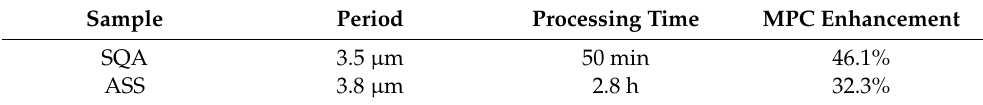
Table 1. Mean pixel contrast index of SQA and